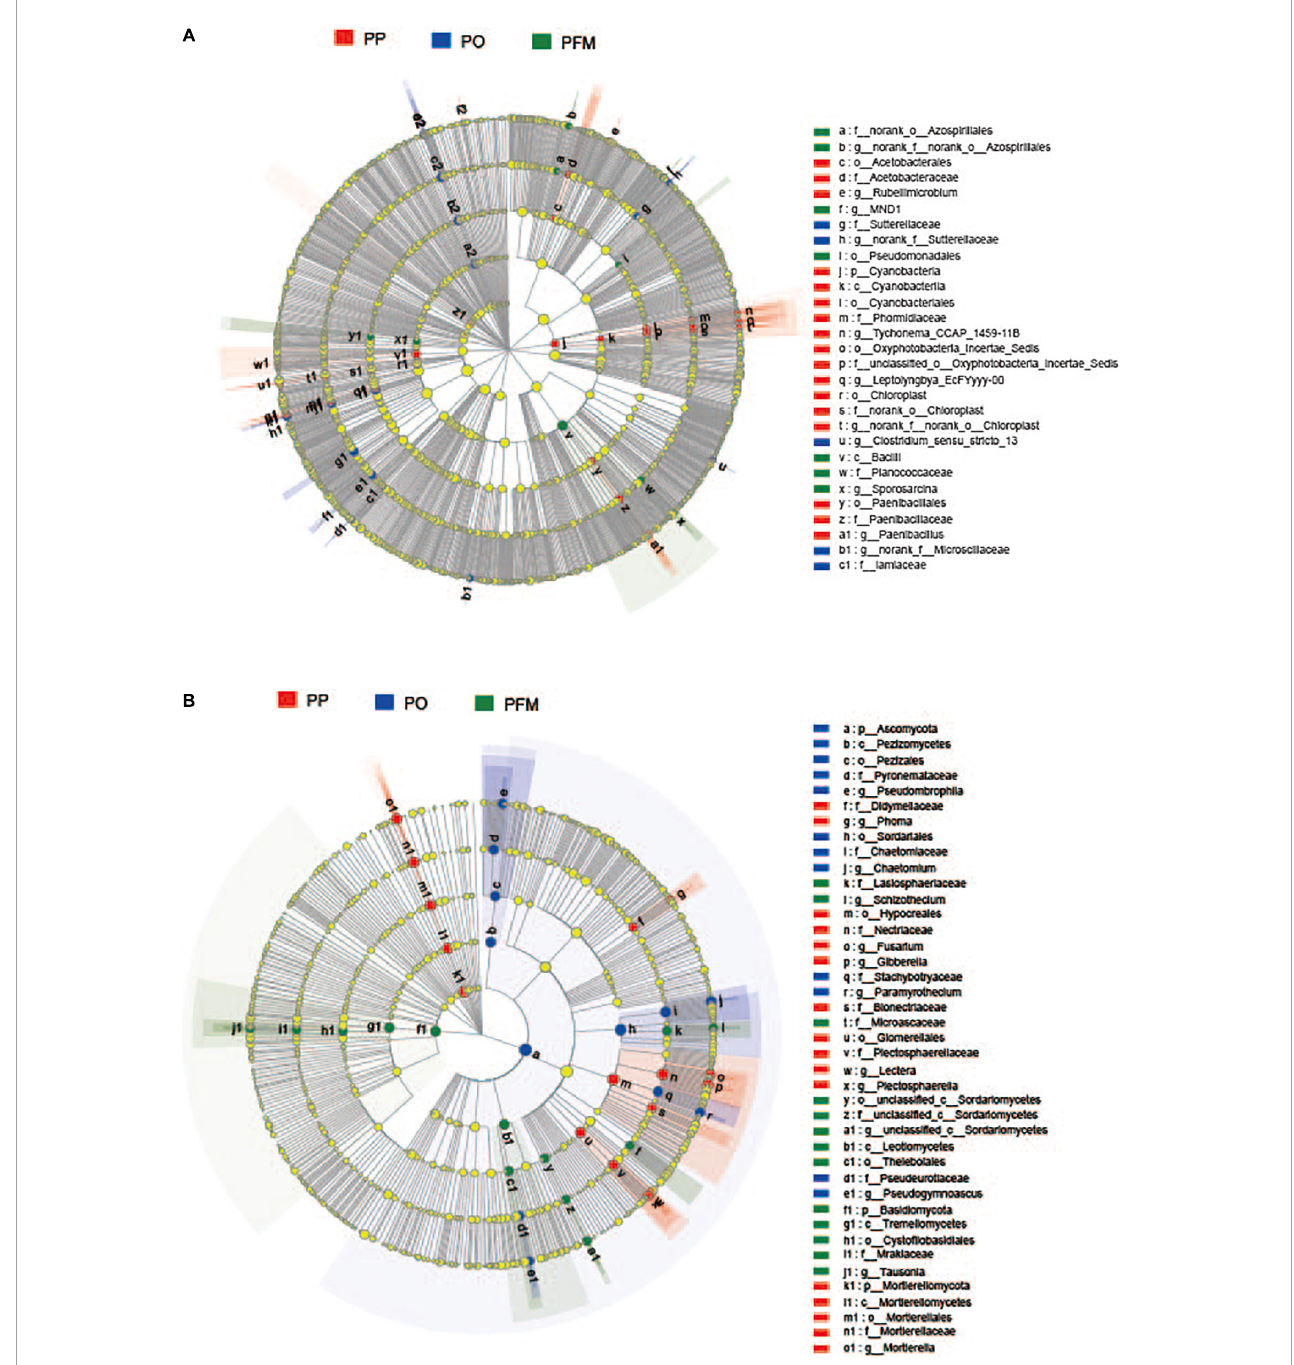
FIGURE3 Cladogram showing the phylogenetic distribution of the bacterial (A) and fungal (B) lineages associated with soil from different crop rotations. Circles indicate phylogenetic levels from domain to genus. PP, potato continuous cropping; PO, potato–oat rotation; PFM, potato–forage maize